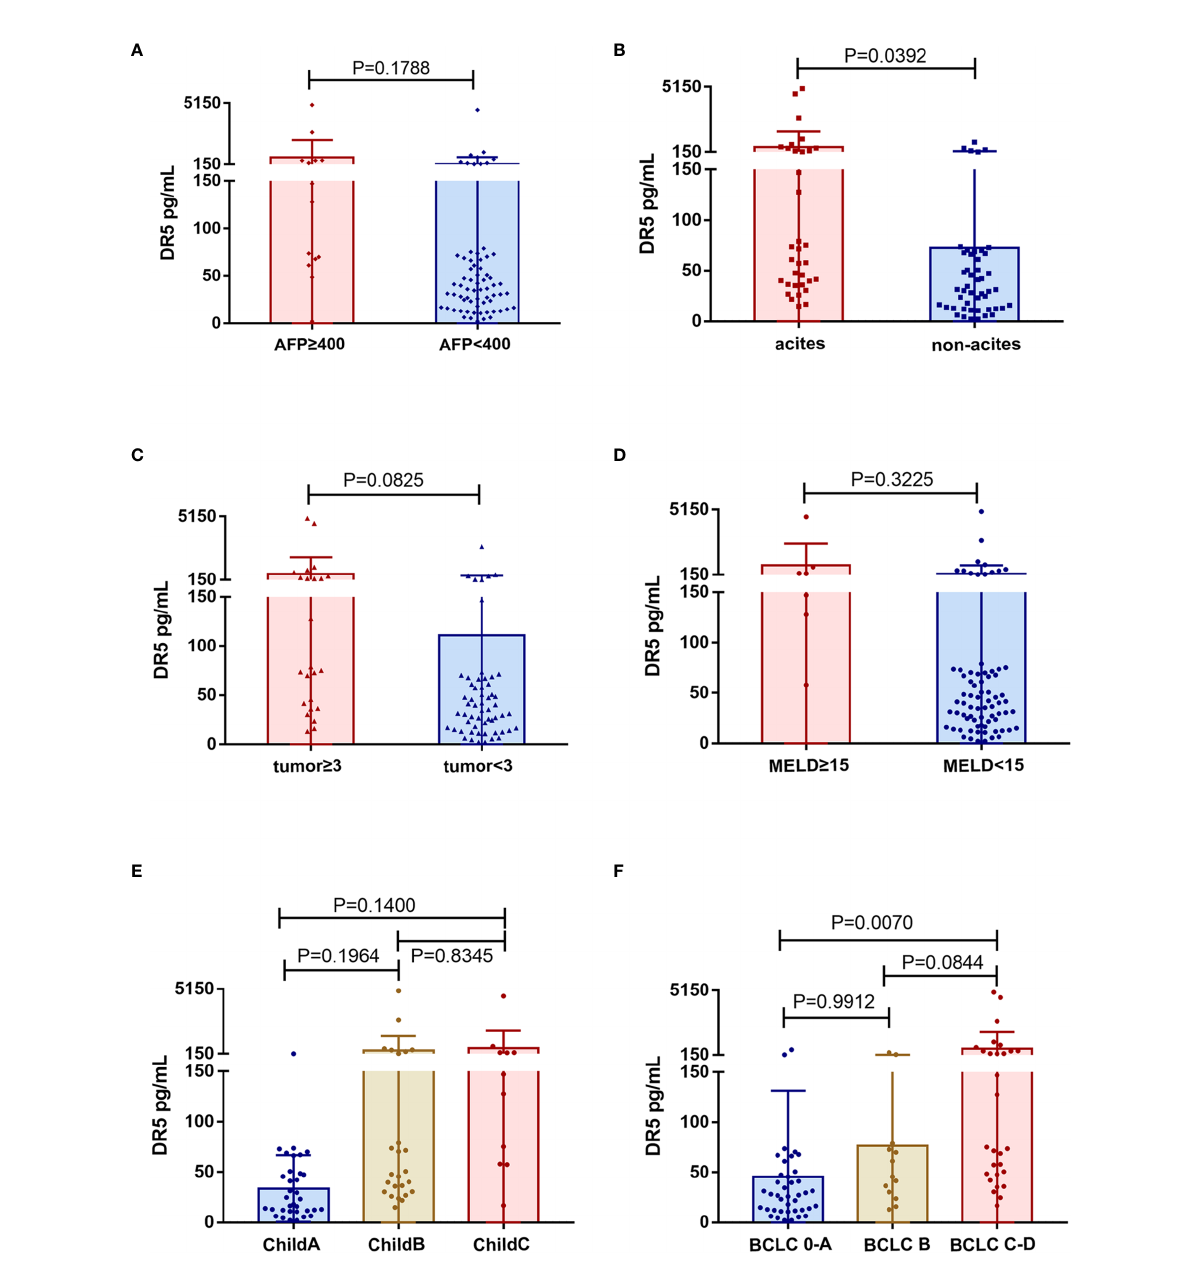
FIGURE 5 Association of serum levels of sDR5 with clinicopathological characteristics from HCC patients. (A) Serum level of sDR5 with AFP level (A) , ascites (B) , tumor number (C) , MELD score (D) , Child-Pugh stage (E) , and BCLC stage (F)